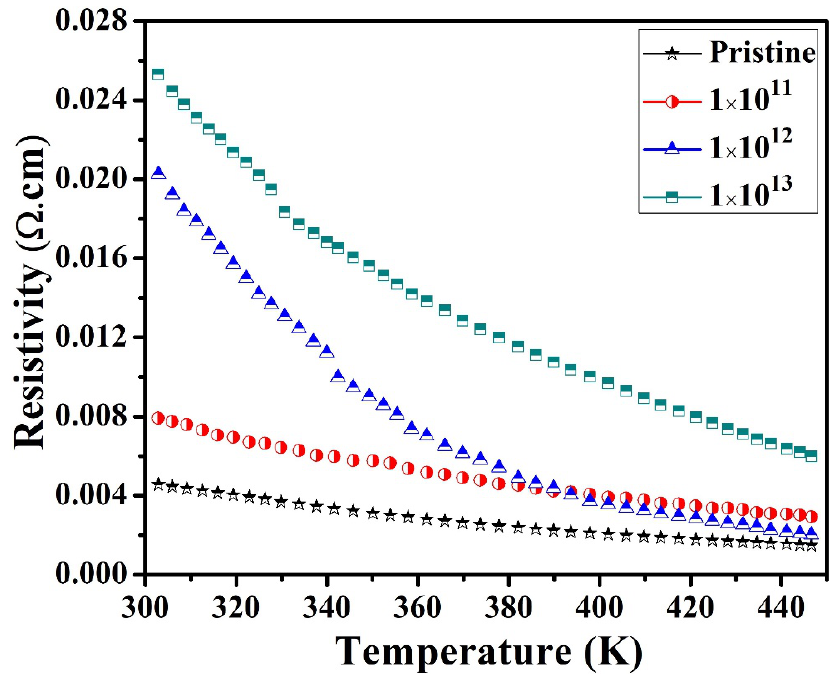
Figure 7. Electrical resistivities ( ρ ) of pristine and irradiated In 2 (Te 0.98 Se 0.02 ) 3 films.